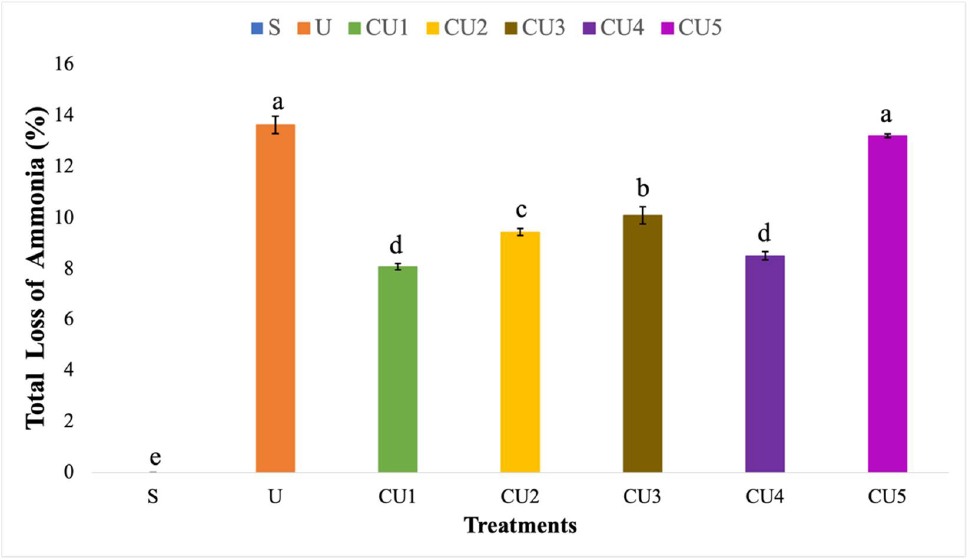
Figure 8. Total ammonia loss under waterlogged conditions. Note: Mean values with different letter(s) indicate significant differences between treatments suing Duncan’s test at p ≤ 0.05. The error bars show the standard errors on the replicates in the means of each treatment.